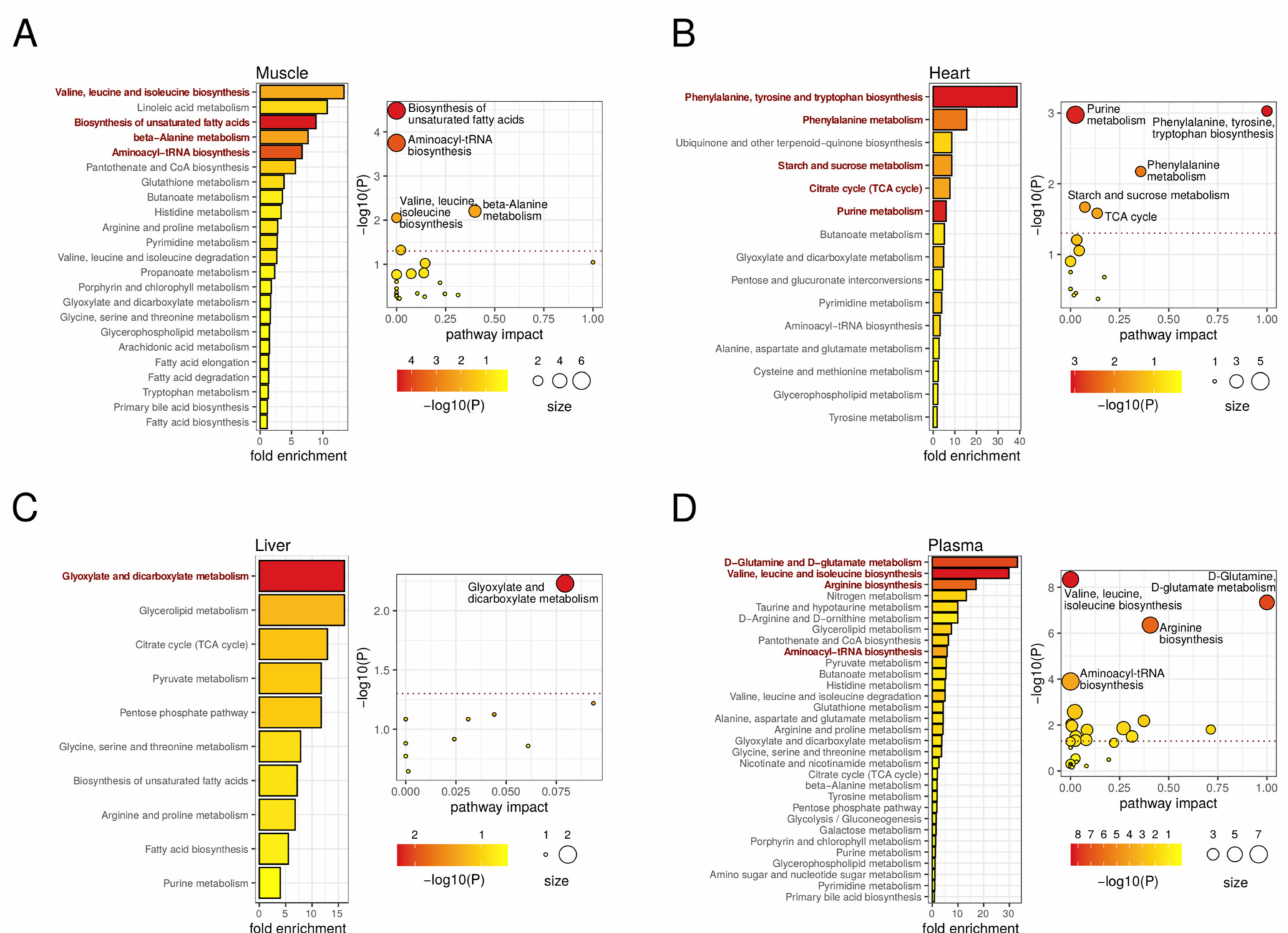
Figure 6. Metabolic pathways involved in autophagy deficiency upon ATG4B loss in mouse tissues. On the left, the bar plots describe altered metabolic pathways with detected fold-enrichment, colored by significance ( − log10 of p -value), across differential metabolites for the muscle ( A ), heart ( B ), liver ( C ), and plasma ( D ) comparisons. On the right, the scatterplots describe the pathway impact, size, and significance of the detected metabolic pathways for muscle ( A ), heart ( B ), liver ( C ), and plasma ( D ). The horizontal dotted line in the scatterplots marks the 0.05 p -value threshold (unadjusted). Representative significant (unadjusted p -value < 0.05) pathways are highlighted in the bar plots and labeled in the